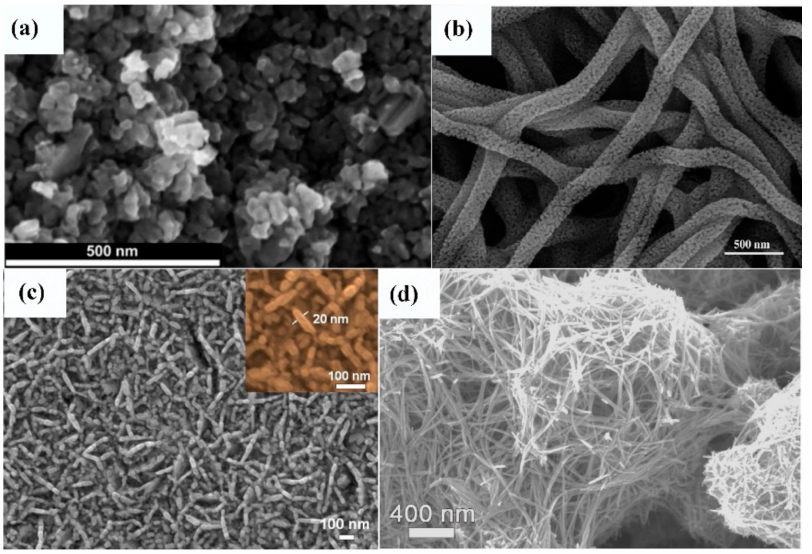
Figure 11. SEM images of: ( a ) WO 3 nanoparticles; ( b ) WO 3 nanofibers; ( c ) WO 3 hollow nanosheet array; ( d ) WO 3 nanomesh, reprinted from Refs. [141–143,145], with permission of Elsevier Ltd., ( b , c